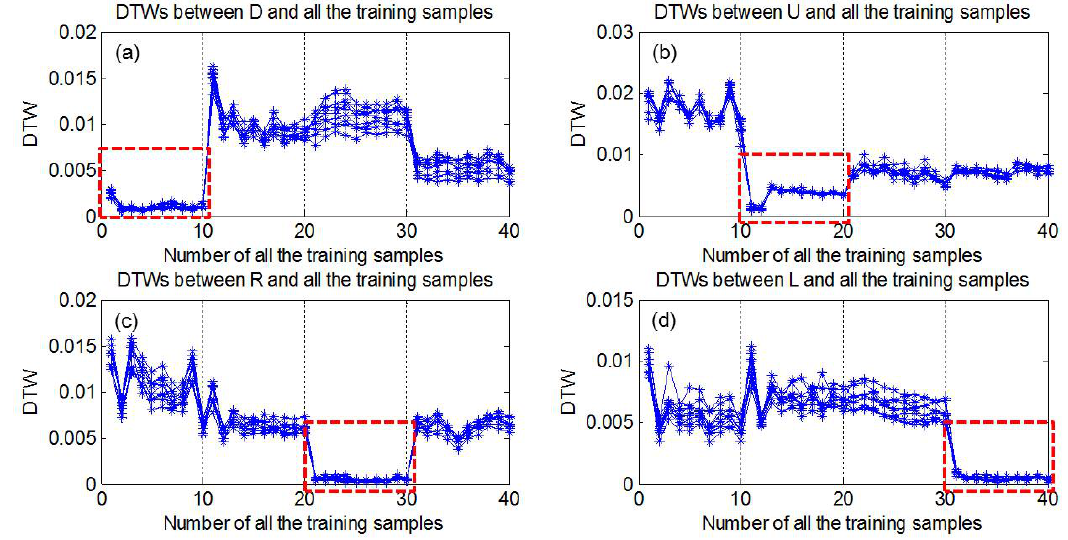
Figure 10. Illustration of DTW cost between partial testing samples and training center. ( a ) Testing samples of movement D; ( b ) Testing samples of movement U; ( c ) Testing samples of movement R; ( d ) Testing samples of movement